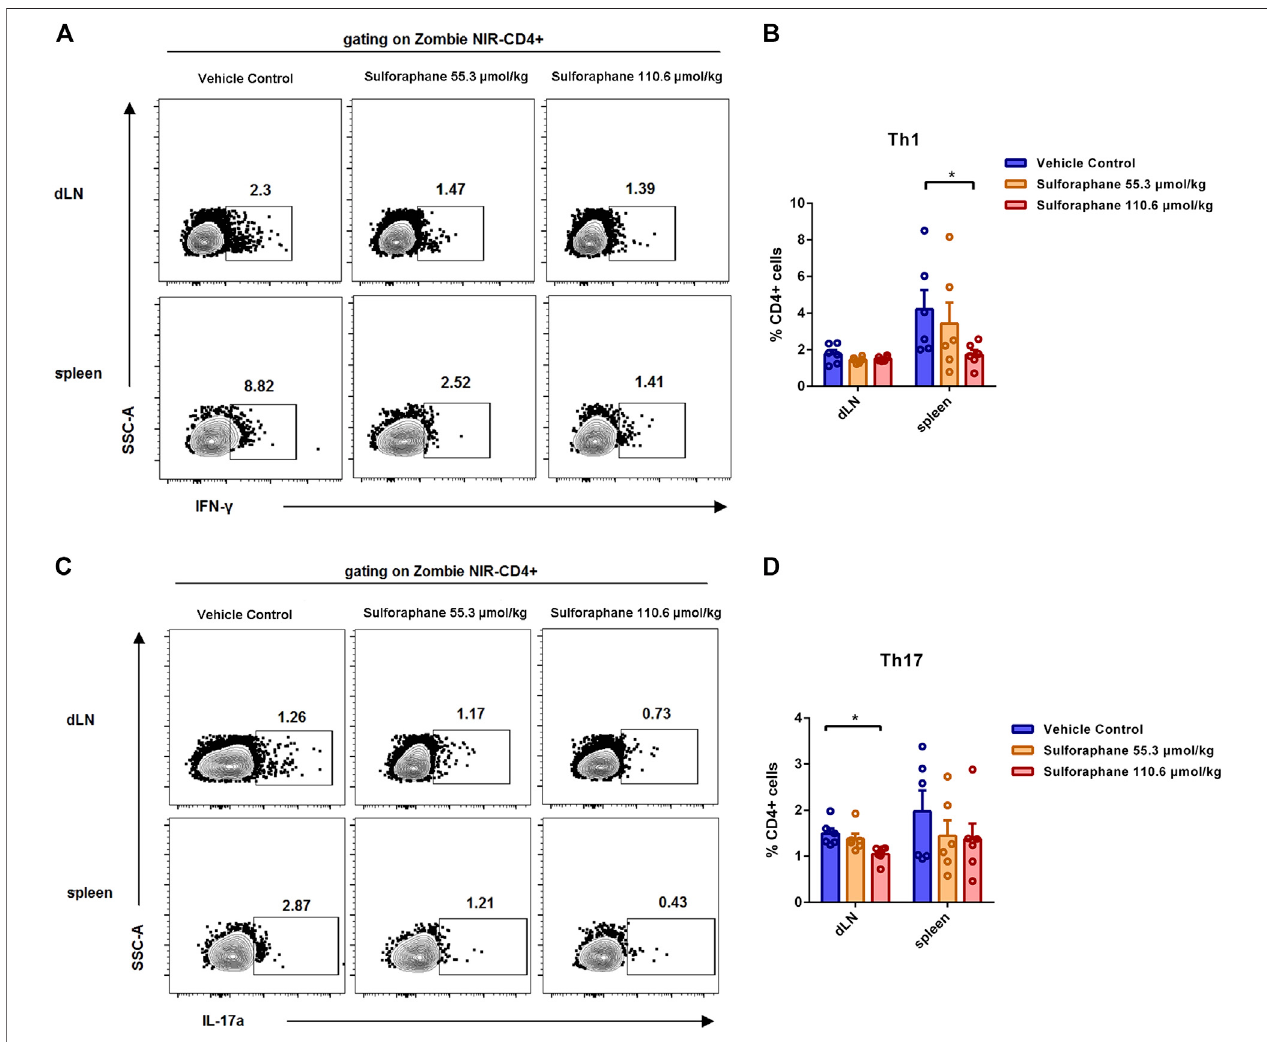
FIGURE 2 | Sulforaphane reduced the proportions of Th1 cells and Th17 cells in IMQ-induced psoriasis-like mice. (A) Representative fl ow cytometric analysis of Th1 cells in the dLNs and spleens from IMQ-induced psoriasis-like mice treated with sulforaphane or vehicle control (n (cid:1) 6). (B) Statistical analysis of (A) . (C) Representative fl ow cytometric analysis of Th17 cells in the dLNs and spleens from IMQ-induced psoriasis-like mice treated with sulforaphane or vehicle control. (D) Statistical analysis of (C) . The data represent the mean ± SEM. * p < 0.05.